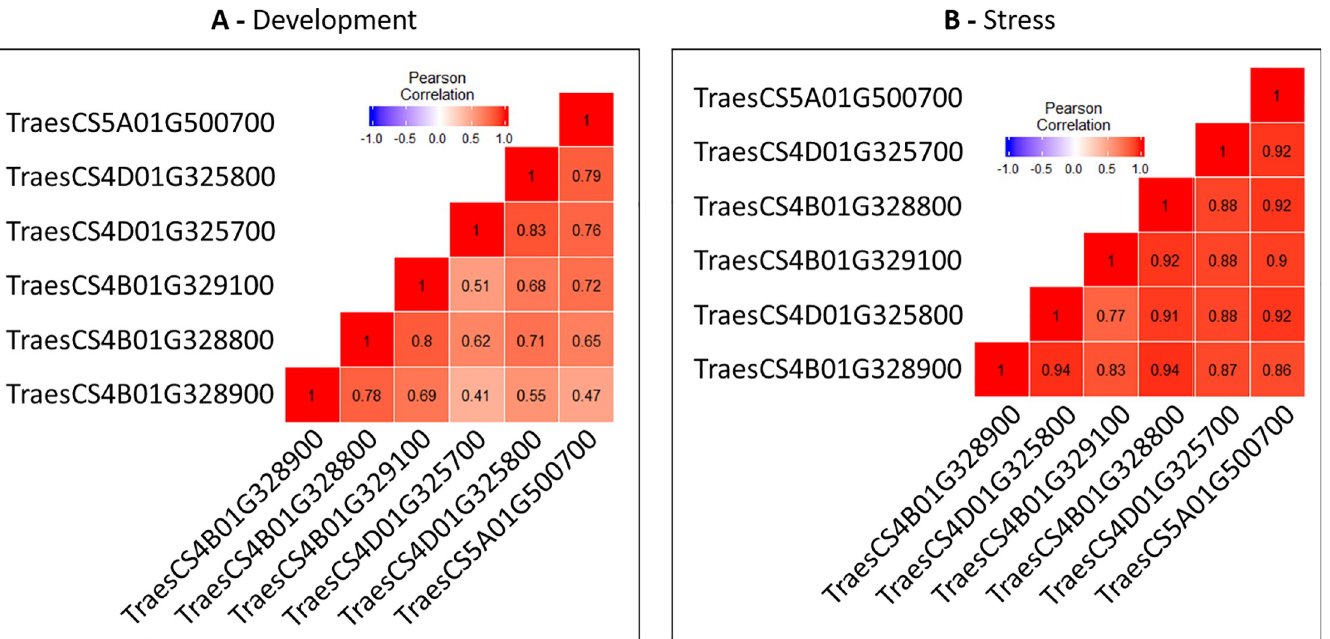
Fig 4. Pearson correlations between duplicated genes of the studied 4B-4D-7B-5A chromosomal regions during development (A) and stress